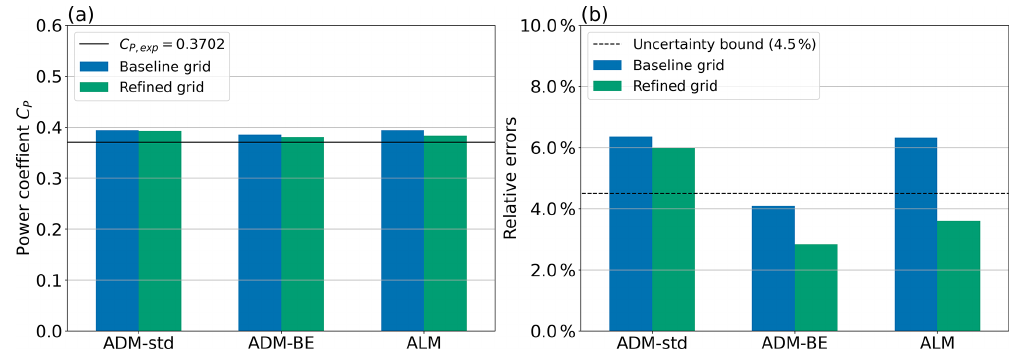
Figure 13. (a) Power coefficients of the first turbine in the turbine array in zero yaw. The solid black line marks the measured power coefficient. (b) Relative errors of the power coefficient compared to the power measurement. The dashed black line marks the uncertainty bound of the power measurement.